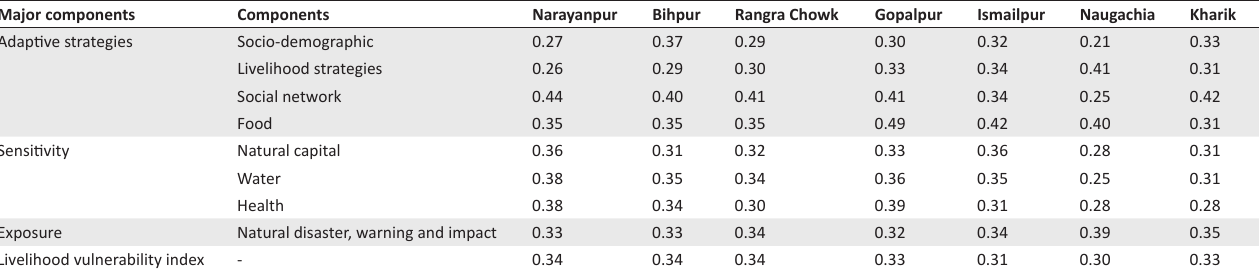
TABLE 3: Livelihood vulnerability index for district blocks. Major components Components Adaptive